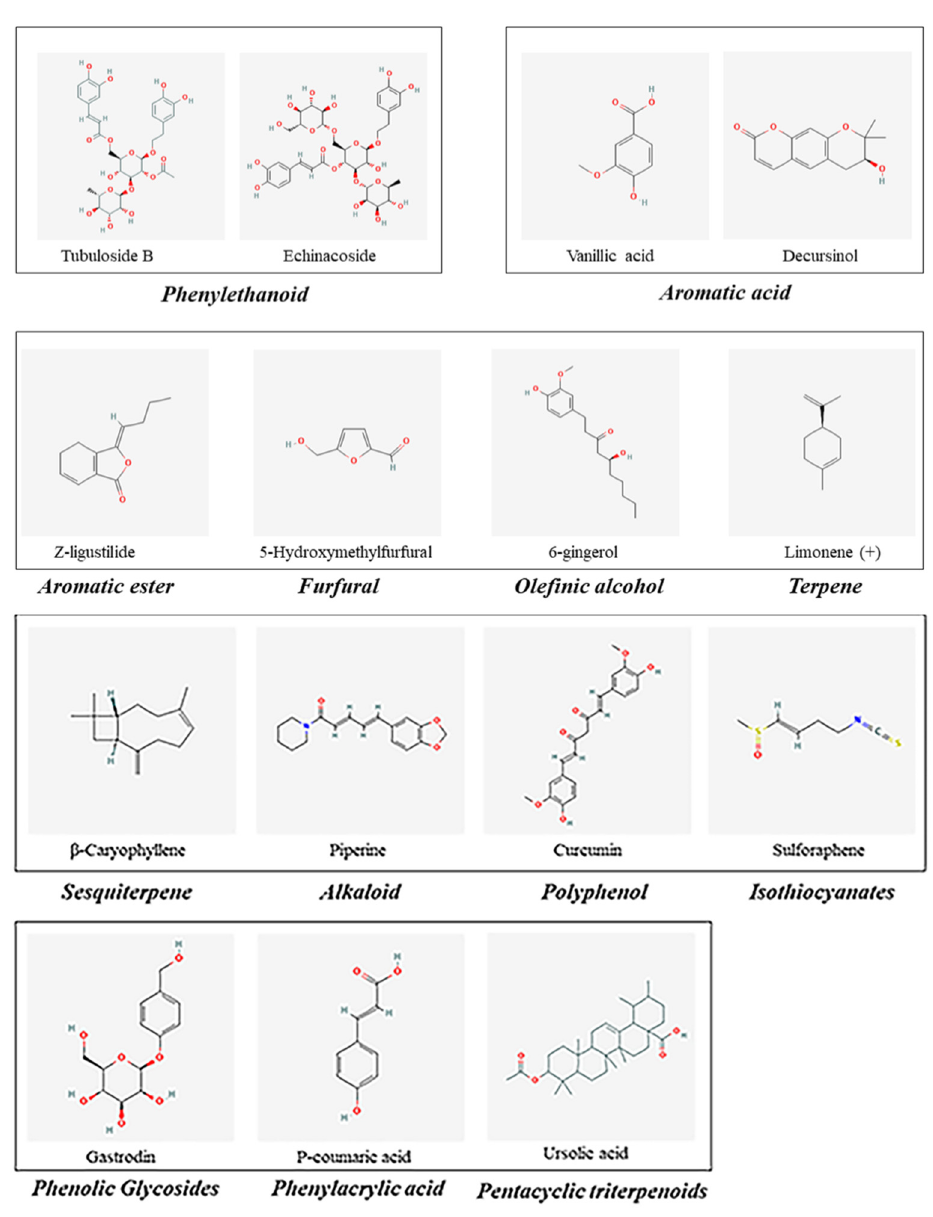
Figure 3. Other active ingredients in